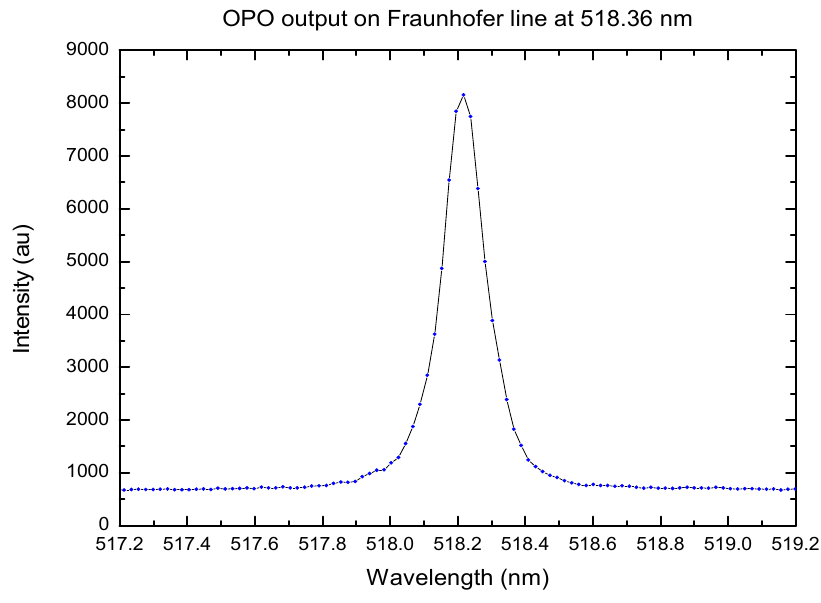
Figure 4. Linewidth of the OPO laser measured by the